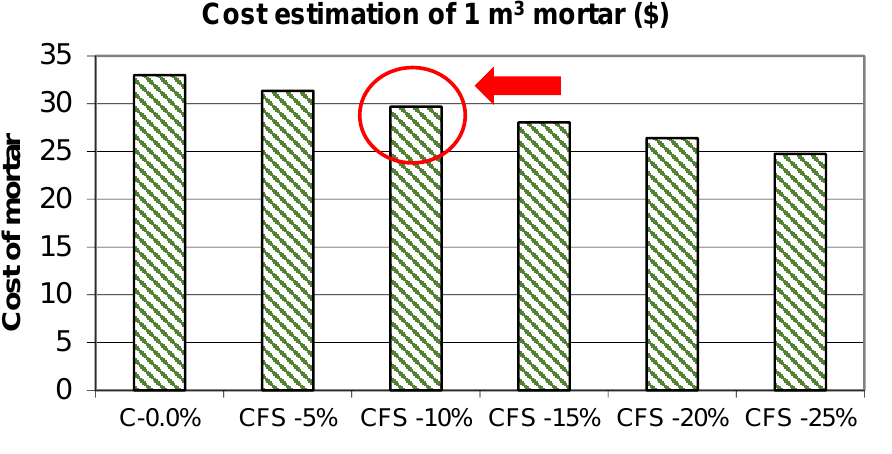
Figure 15. Cost of CFS mixtures (in $).